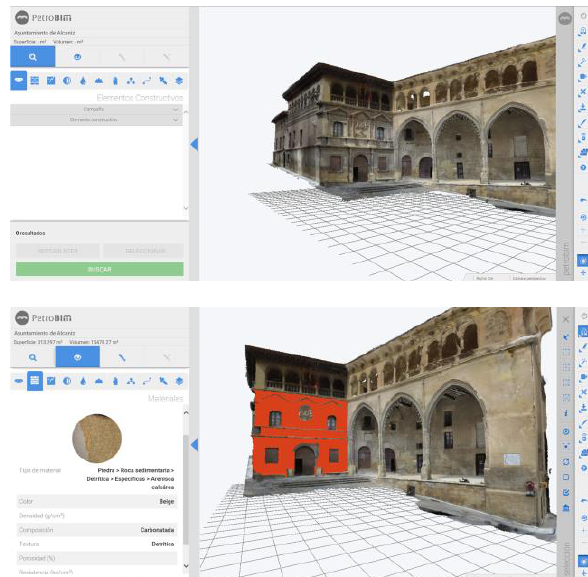
Figure 4. Web platform Petrobim with the model mesh and viewer of the material module of the facade of the masonry factory